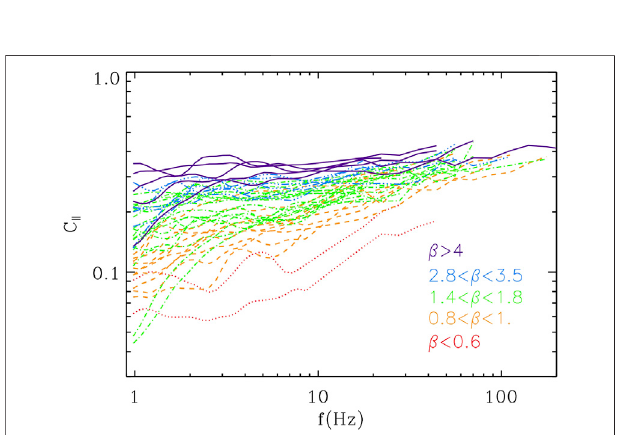
FIGURE6| ExamplesofClusterFGM(black)andSTAFF(red)spectraof magnetic compressibility C (cid:3) as a function of the frequency measured in the spacecraft frame.